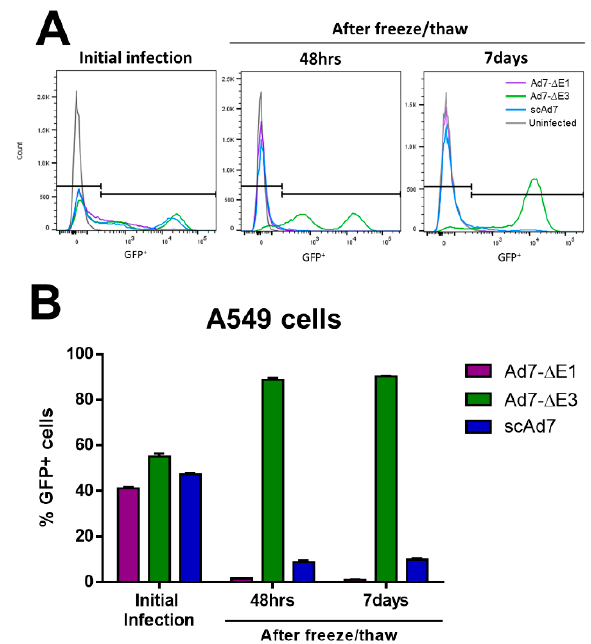
Figure 4. Virus progeny of the three Ad7 viruses after infection of noncomplementing A549 cell lines. Noncomplementing A549 cells were infected at an MOI of 1 with the indicated virus. At 48 h after this initial infection, flow cytometry was performed to examine GFP + cells ( A ) and quantitate the percent GFP + cells ( B ). A duplicate well of infected cells was harvested, freeze / thawed three times to release virus progeny, and the supernatant was added to new A549 cells. After addition of the freeze / thaw supernatant, cells were harvested for flow cytometry 48 h and 7 days after infection to examine the presence of infectious virus progeny. Infection was performed in triplicate, and error bars represent